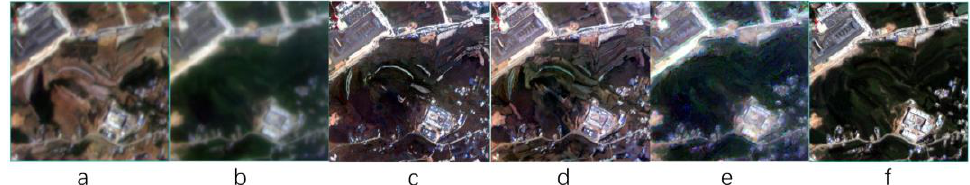
Figure 3. ( a ) PS image on 15 April; ( b ) PS image on 10 July; ( c ) fusion image by FSDAF on 10 July; ( d ) fusion image by STDFA on 10 July; ( e ) fusion image by Fit_FC on 10 July; ( f ) GF-2 verification image on 13 July.